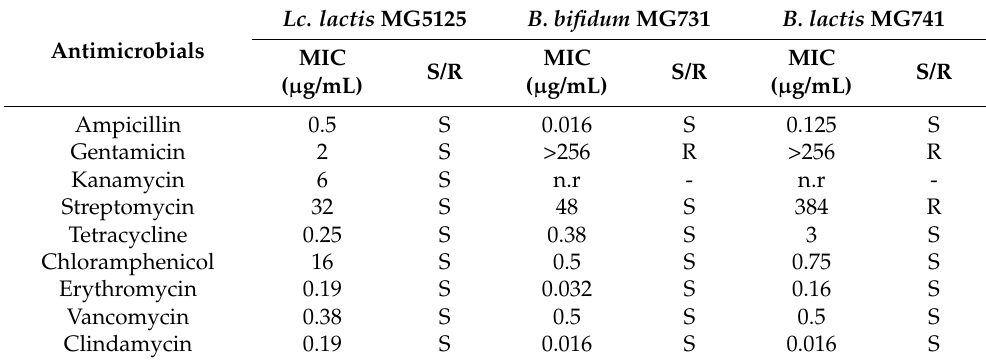
Table 1. Determination of the MIC values of the antibiotics tested for probiotics.